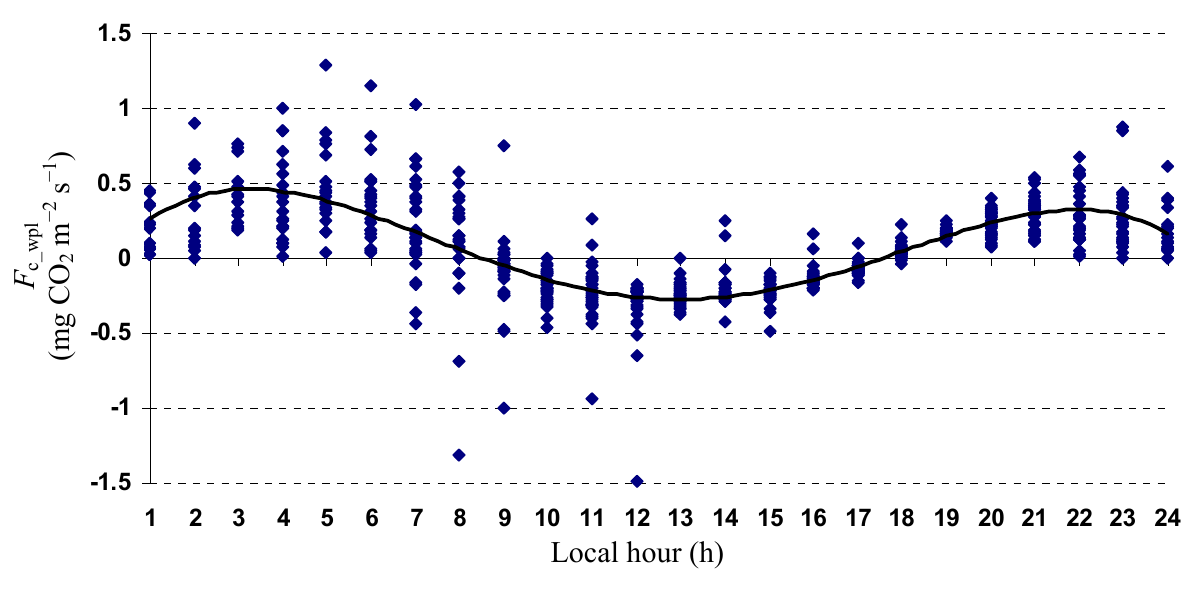
dataset for Yenicaga peatland in August Figure 5. A quartic function fitted to F c_wpl of 2010: F (mg CO m − 2 s − 1 ) = 0.3242 h − 0.0696 h 2 ± 0.0044 h 3 – 9 × 10 − 5 h 4 ; c_wpl 2 ( R 2 = 0.5963; SE = 0.1957; n = 620; P < 0.001). adj